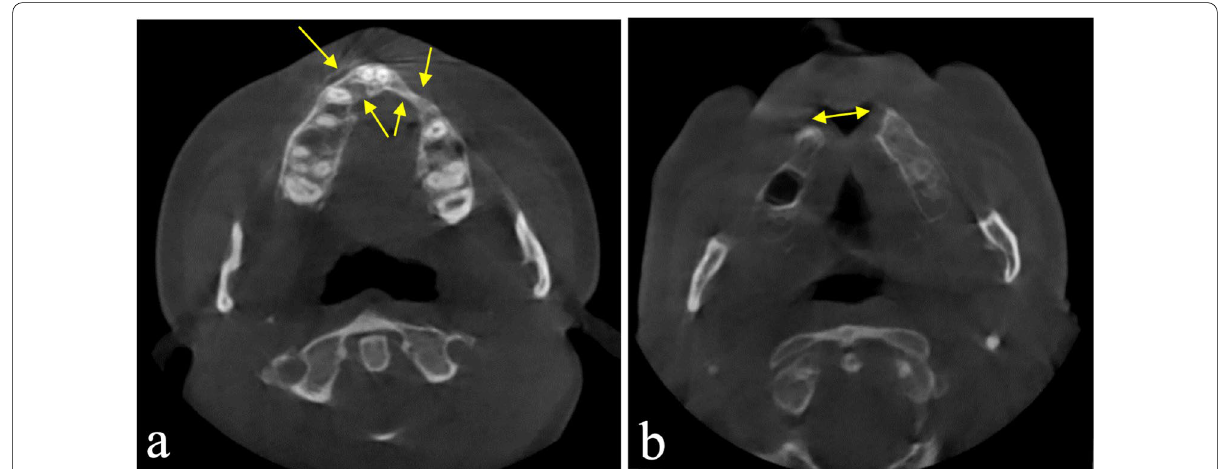
Fig. 2 Typical radiologic findings in CLP patients. Cone‑beam CT scan showing an axial slice with a formerly bone‑grafted premaxilla displaying compromised horizontal bony dimensions for the left and right lateral incisor region (arrows) including the left canine in a partially edentulous 18‑year‑old female patient with van der Woude syndrome ( a ). Cone‑beam CT scan from a patient following complete loss of the premaxilla during treatment for a CLP deformity elsewhere ( b ) (patient from Fig.